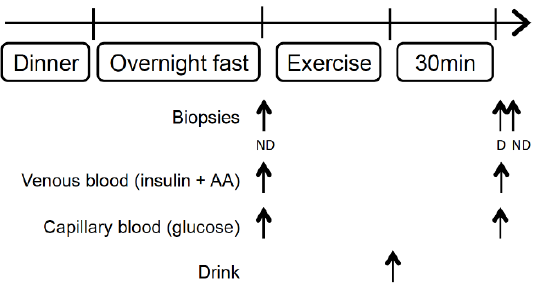
Figure 1. Schematic study protocol. D, dominant; ND, nondominant; AA, amino acids. The exercise consisted in single leg extension of the dominant leg.